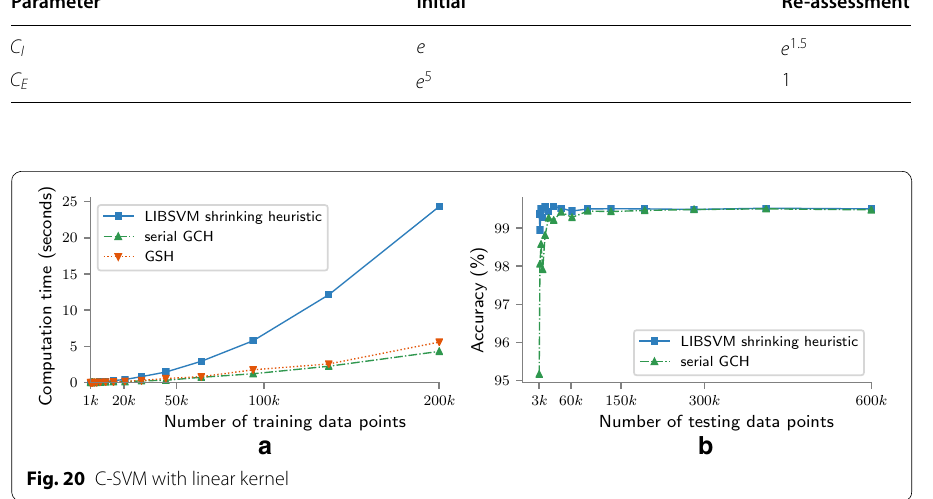
Fig. 20 C-SVM with linear